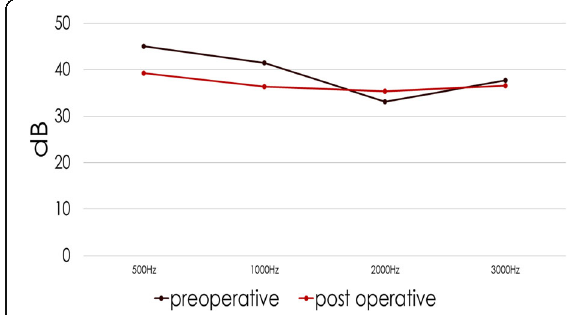
Fig. 1 Frequency wise average pre-op and post-operative ACT in dB ( n